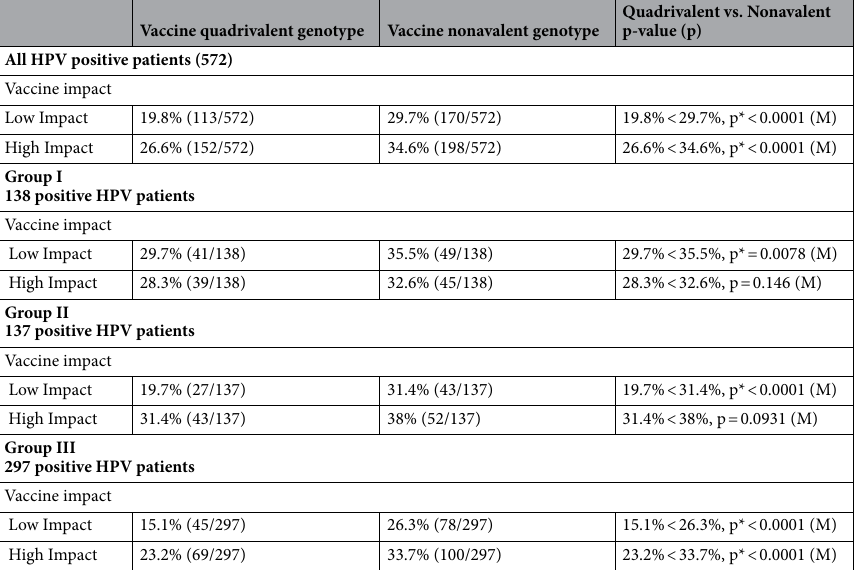
Table 4. Comparison between vaccine nonavalent and quadrivalent, considering all positive HPV patients and all subgroups defined in this study. *Significant test; M McNemar exact